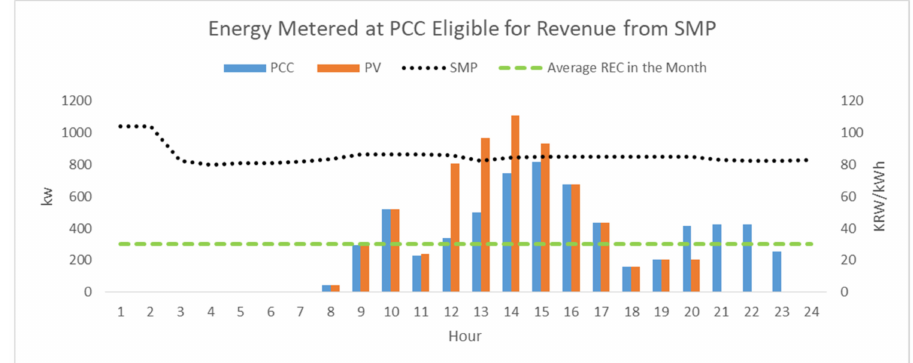
Figure 7. Intraday control status on the output compared with patterns of the